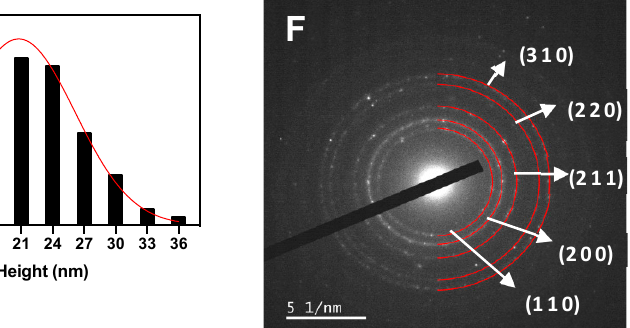
Figure 3 . ( A – C ): High-Resolution Transmission Electron Microscopy (HR-TEM) images of Ca 0.25 Mg 0.75 Fe 2 O 4 ferrite nanoparticles at different magnifications; ( D ): Aspect ratio distribution histogram; ( E ): Size histogram and distribution fit (R 2 = 0.96) and ( F ): Small Area Electron Diffraction (SAED) image with indexed diffraction planes.